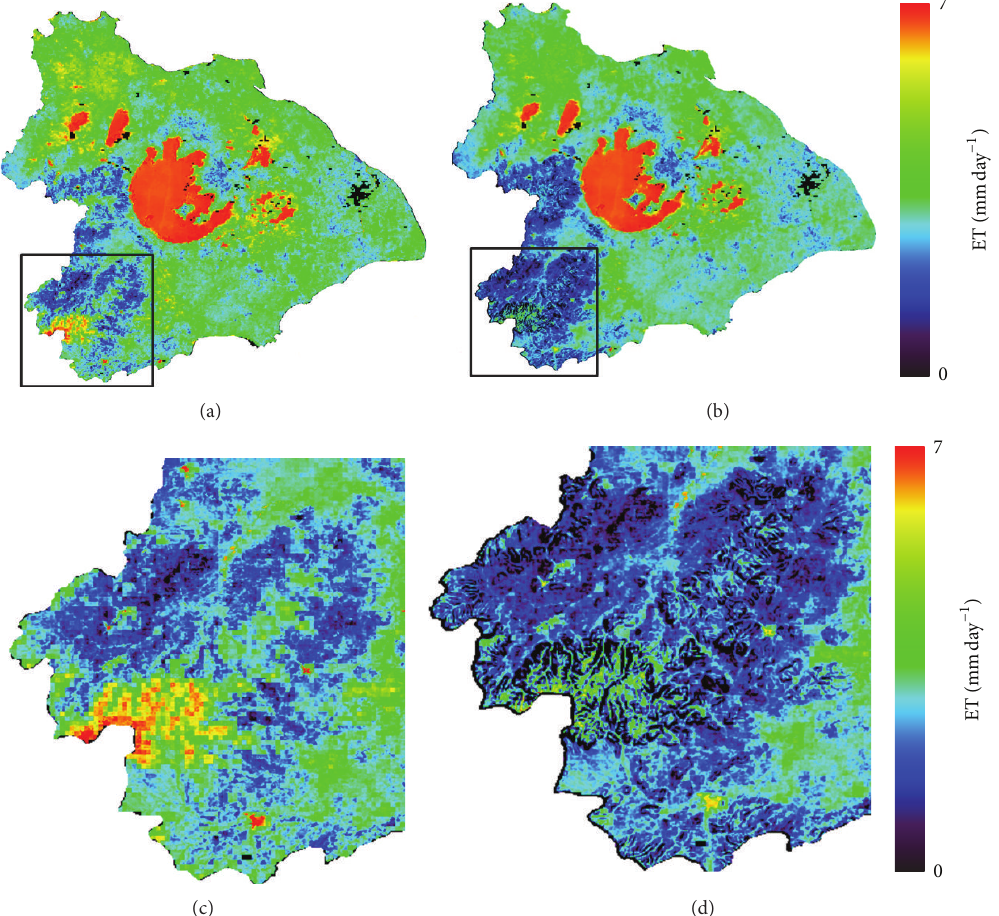
Figure 3: The evapotranspiration map over the Taihu Basin for September 26, 2006, (a) before the topographic correction and (b) after the topographic correction. The area in the black square is the selected mountainous area. Zoom in on the selected area for the (c) ET before the topographic correction and (d) ET after the topographic correction. Except for the low values in the selected area, the black scatter indicates missing data.